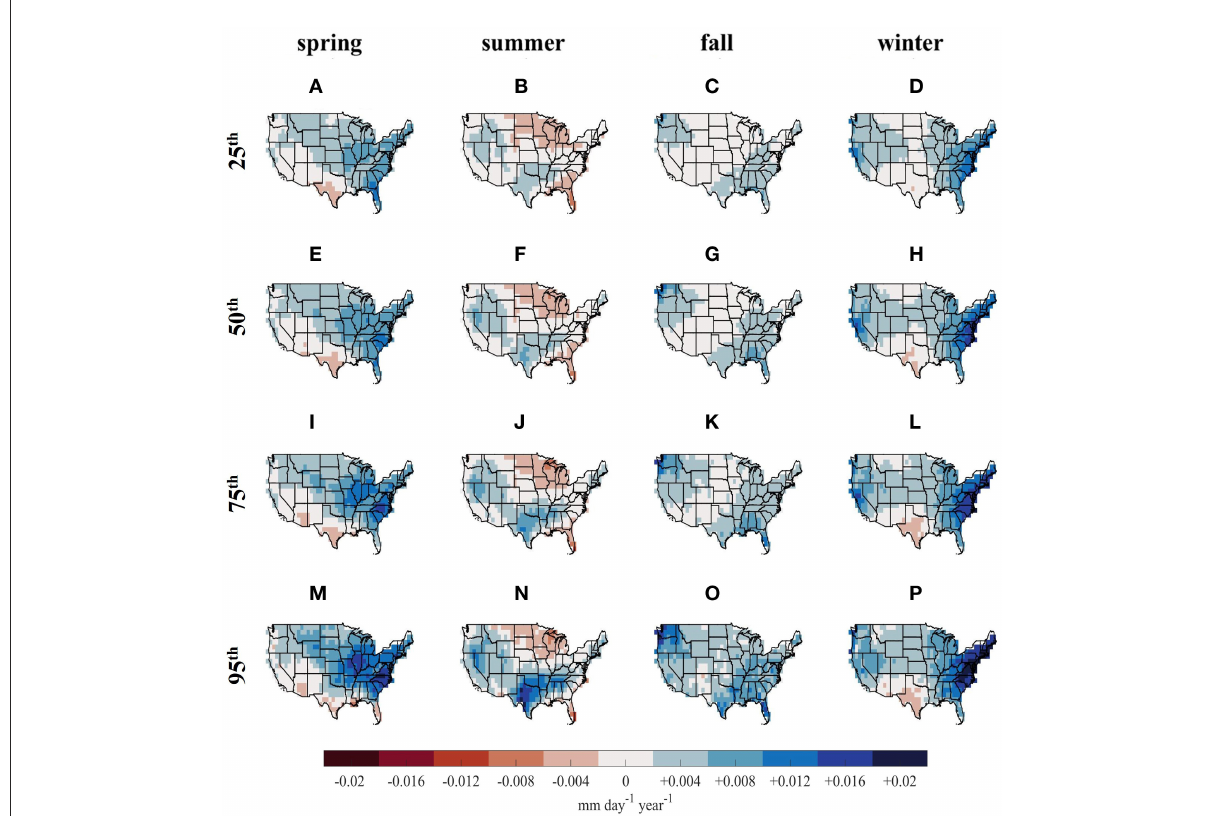
FIGURE4 CONUS spatial distribution of projected SDII (mm/day/year) Sen’s long-term trends of projected SDII (mm/day/year) from 2015 to 2100 using CESM2-LE for different quantiles (rows) across seasons (columns). Cold (blue) colors represent wetting trends, whereas warm (red) represents a drying trend, and no change is highlighted in the white color. The trend magnitudes are shown as; lower 25th [spring (A) , summer (B) , fall (C) , and winter (D) ; median 50th, (E–H) ; above median 75th, (I–L) ; and extreme 95th (M–P)